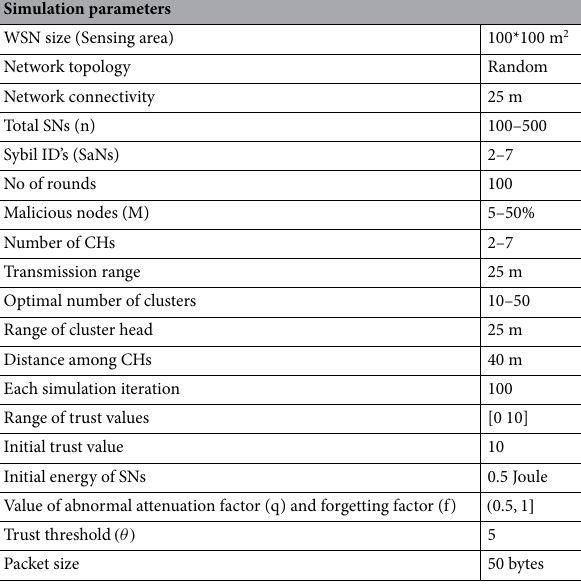
Table 4. Simulation